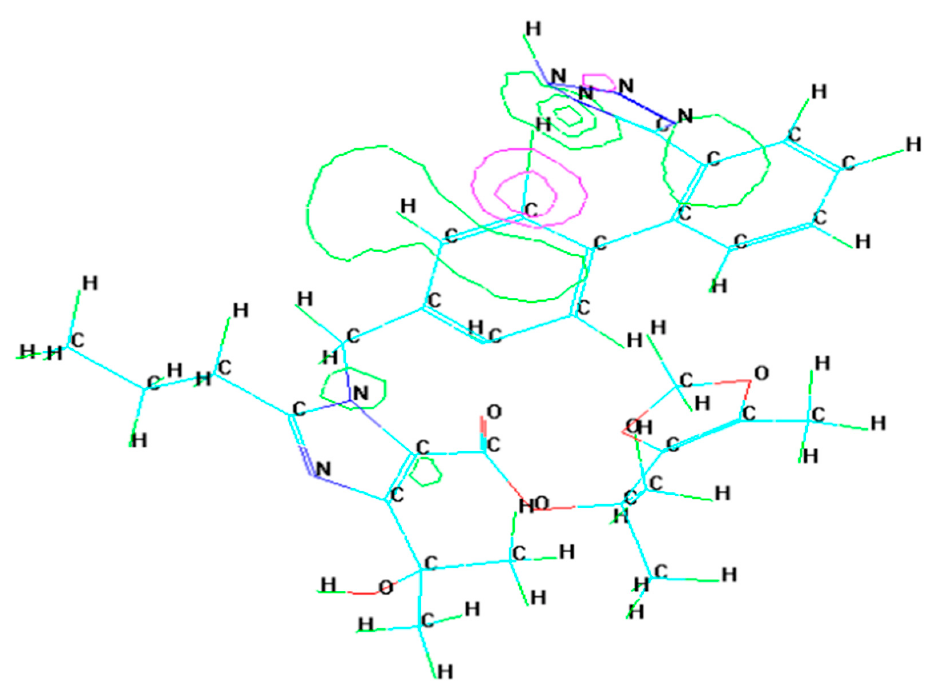
Figure 4. LUMO energy state of olmesartan.